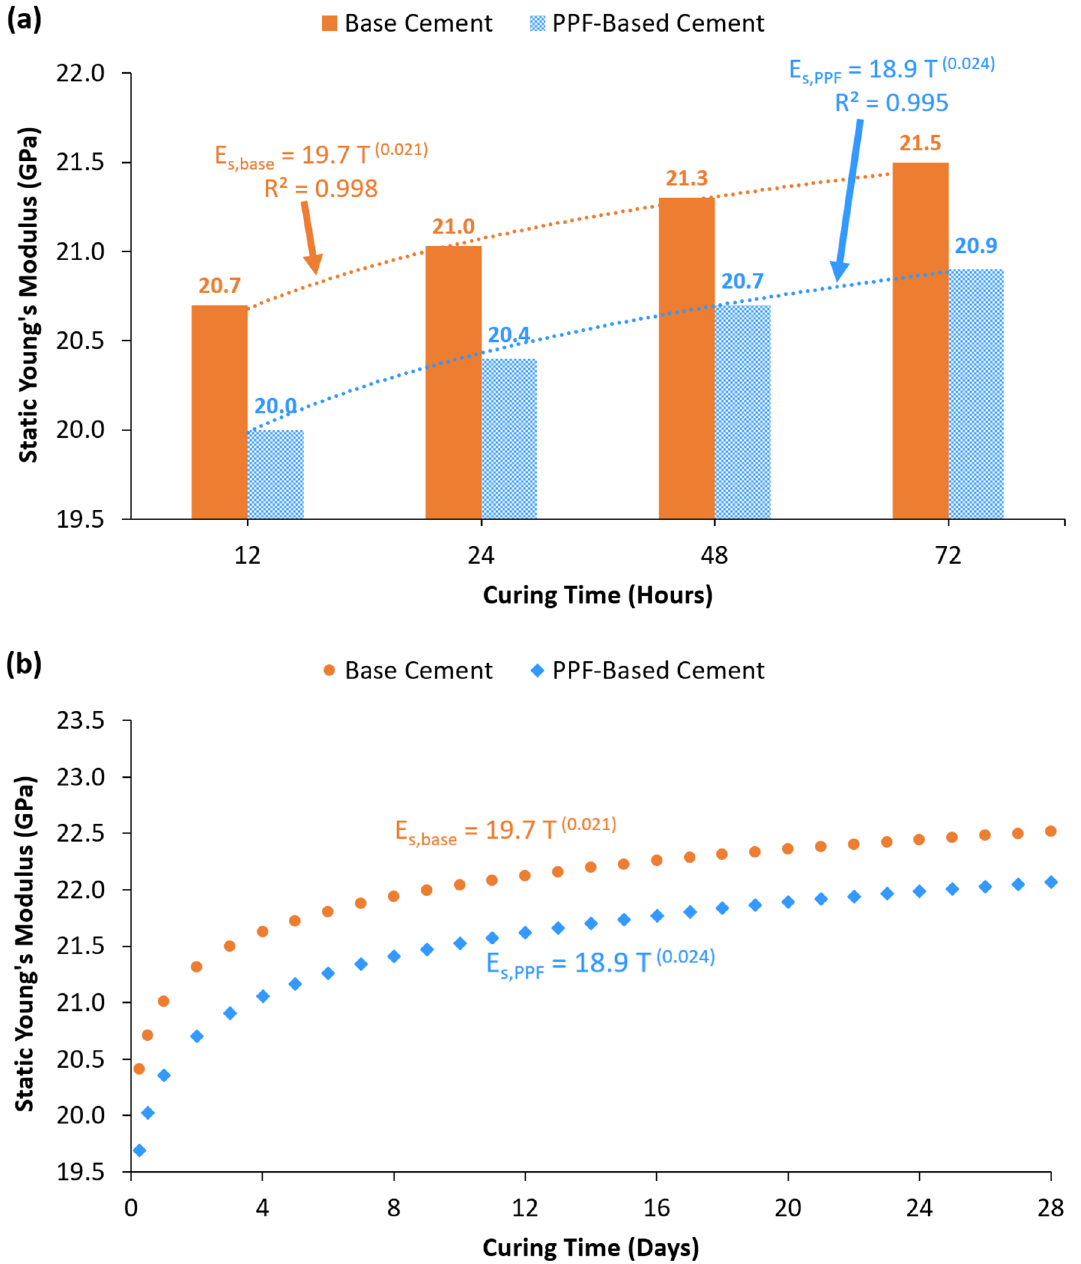
Fig. 9 Young’s modulus for polypropylene and base specimens at various stages of curing. a The findings of the Young’s modulus during the early curing times. b The anticipated variations in Young’s modulus over 4